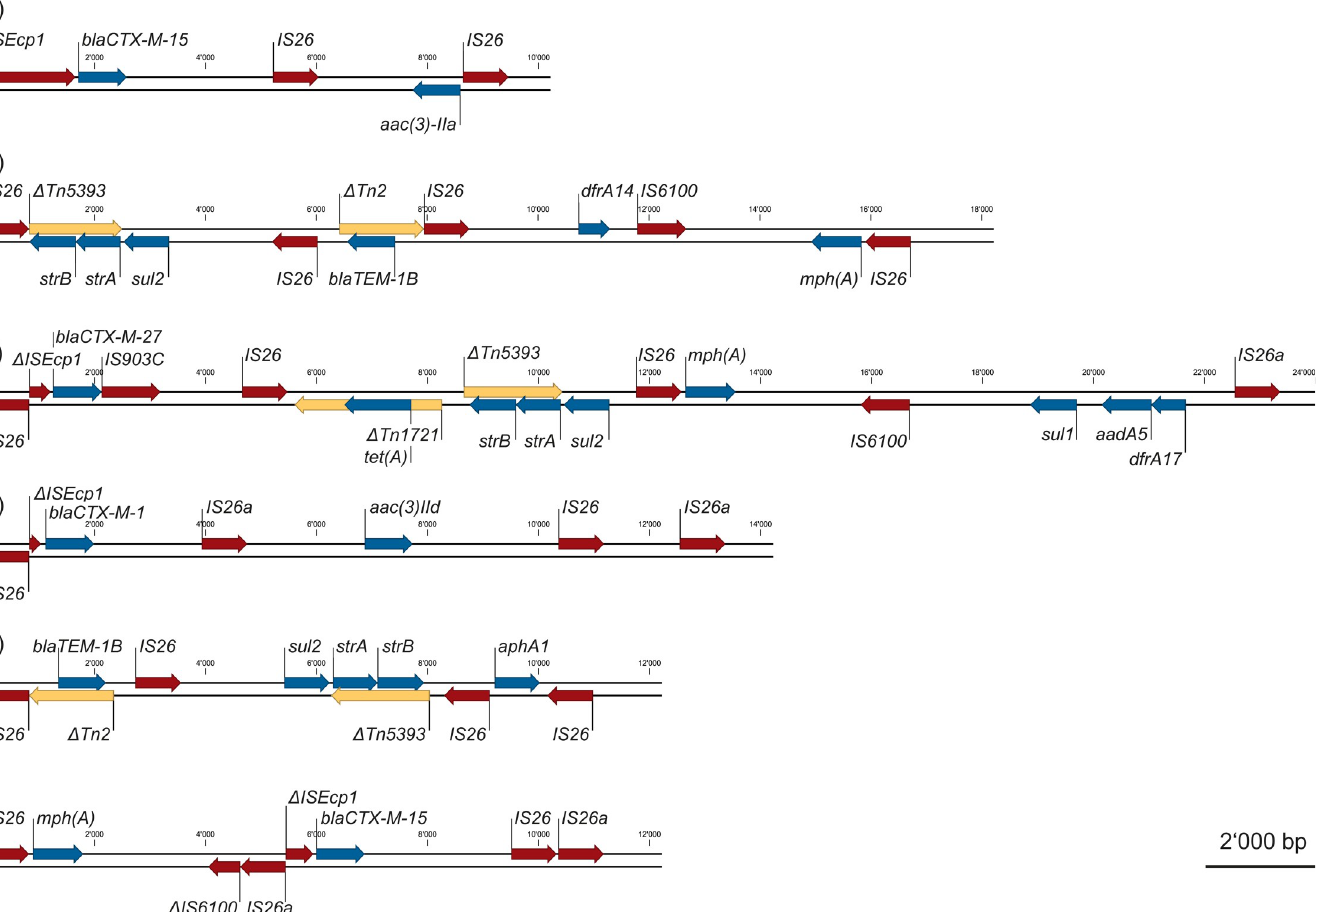
Fig 4. Representative ARG regions displaying ARG and associated insertion sequences. ESBL strains H2 scaffold II (a) and I (b), H6 scaffold I (c), H17 scaffold II (d), H25 scaffold I (e), and H38 scaffold I (f). IS, insertion sequence; Δ IS, partial insertion sequence; Tn, transposon; Δ Tn, partial transposon. Red: insertion sequences; blue: ARG; yellow: